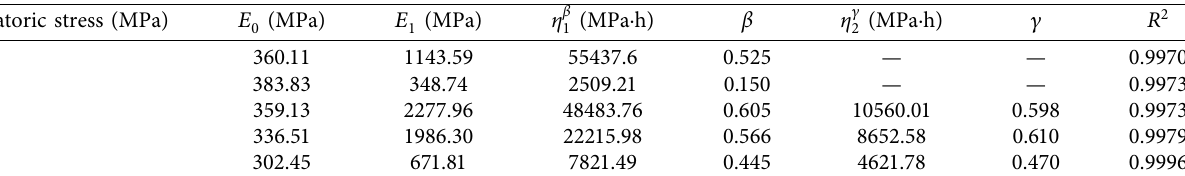
Figure 10: Mesh sketch of calculation model. Table 1: Model parameter identification results.